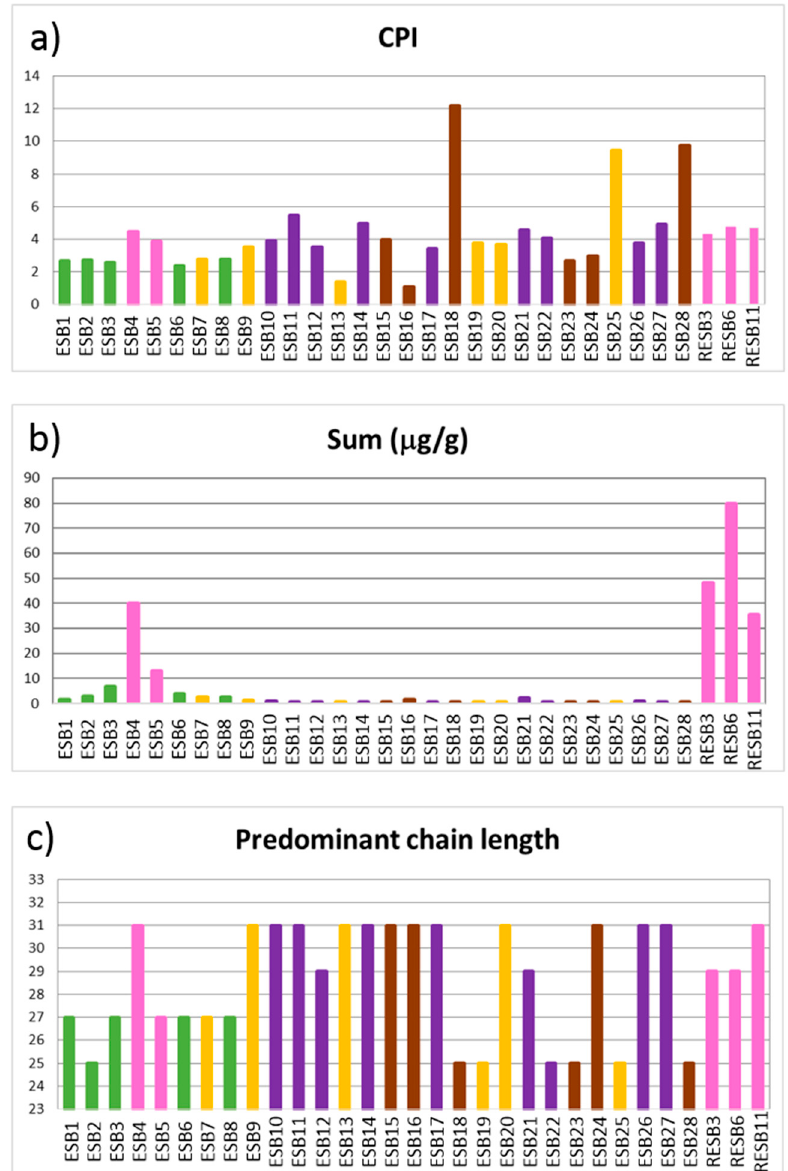
Figure 8. Projection of the proxies from the n -alkanes. ( a ) Carbon preference index (CPI); ( b ) Sum of the concentration of all the n -alkanes; ( c ) Predominant chain length (PCL). (Green): green clays; (Pink): pink clays; (Purple): illitic samples; (Brown): sandy samples; (Yellow): carbonatic samples. The predominant n -alkane chain varies between C 25 , C 27 , C 29 or C 31 . (Figure 8c) indicating a major input from aquatic macrophytes and terrestrial plants as the C 25 homologue is predominant in the former [46], and C 27 , C 29 or C 31 are abundant in the latter [45,51–54]. This interpretation coincides with that of the average chain length (ACL; [55], calculated as [(C i × i + C i+1 × (i + 1) + C i+2 × (i + 2) ... + C n × n))/( Σ C n+1 + C n+2 + ... + C n ), with i = 13, n = 33], which is a good proxy for distinguishing between the predominance of low vs. high molecular weight n -alkanes [54,56]. The ACL oscillates between 25 and 29 (Figure 9a), linked to a major input from aquatic macrophytes and terrestrial plants. However, there is no evidence of a relationship with the mineralogy because these values differ in samples from within the same